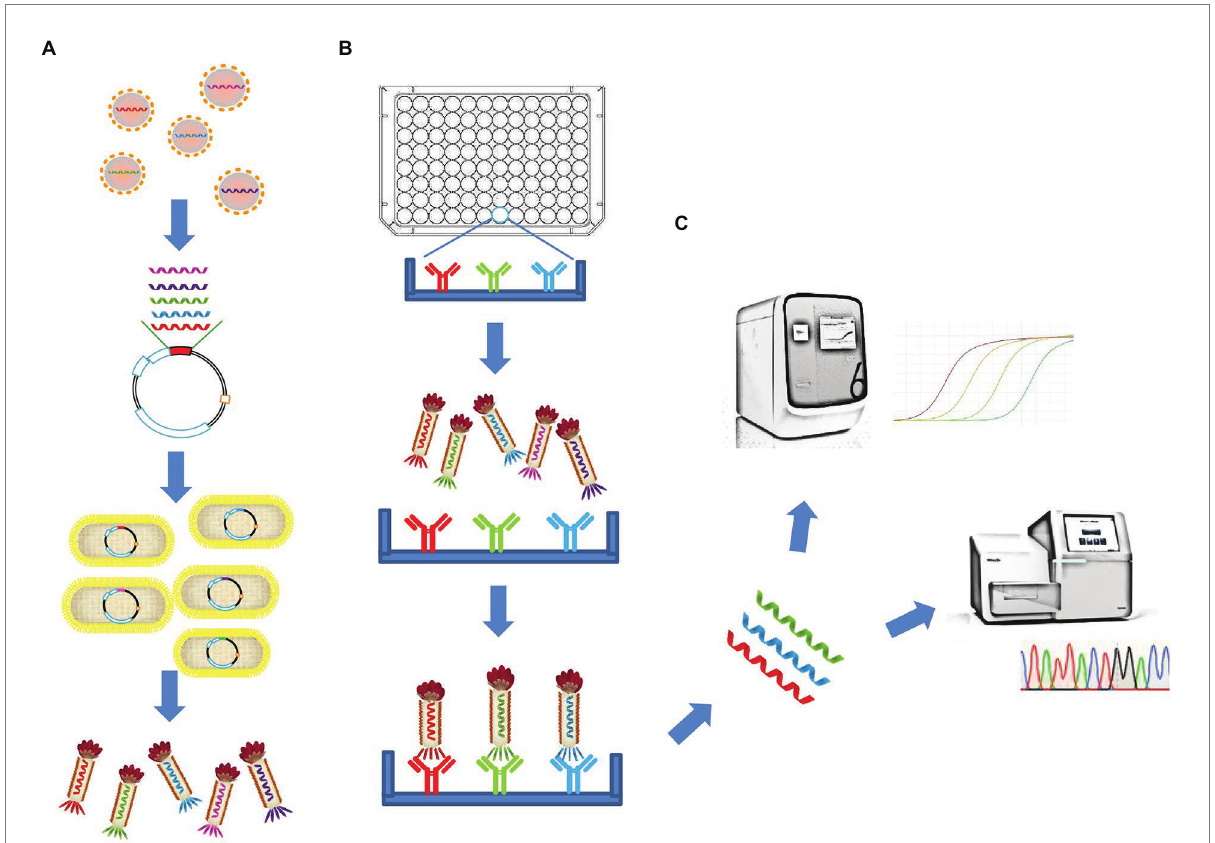
FIGURE 1 Schematic illustration of the polyvalent phage display system and the Pi-mqPCR assay. (A) Construction and synthesis of the recombinant phage. (B) Phage immunoprecipitation. (C) Real-time immuno-PCR and high-throughput DNA sequencing